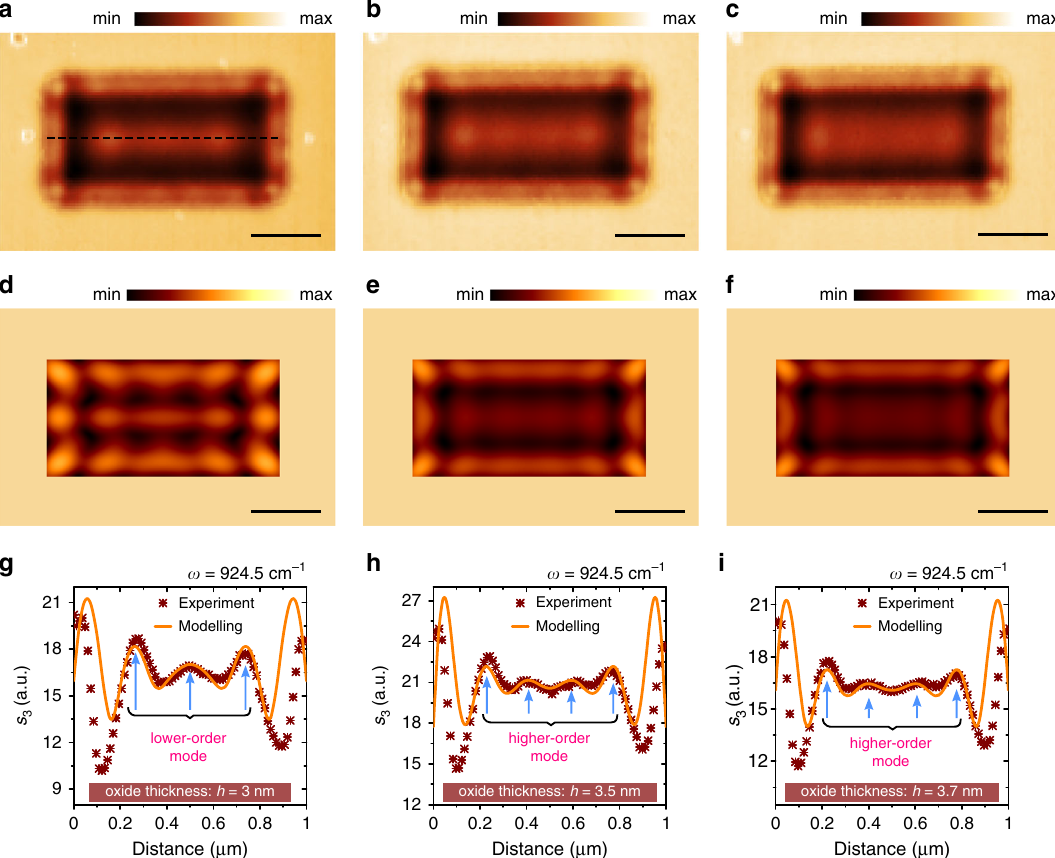
Fig. 3 Tuning germanium resonator modes by sub-nm oxidation. a – c Near- fi eld images of 7-nm thick 1000×500nm resonator recorded at ω ¼ 924.5cm − 1 for different oxide thickness. d – f Modelling of the modes corresponding to experimental images. g – i Experimental and modelled near- fi eld distributions along the central horizontal cross-section (as highlighted with dashed line in image a ) of the resonator modes in data a – f . Left a , d , g , middle b , e , h and right c , f , i data columns correspond to oxide thickness highlighted with arrows in Fig. 1c, which is labelled on images g , h and i . All scale bars are